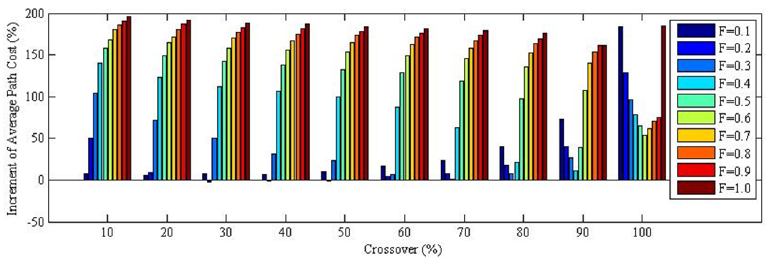
Fig 10. Average path cost changes in % when compared to the optimized parameter setting at maximum generation number of 1000 “ Table E in S1 Dataset. ”